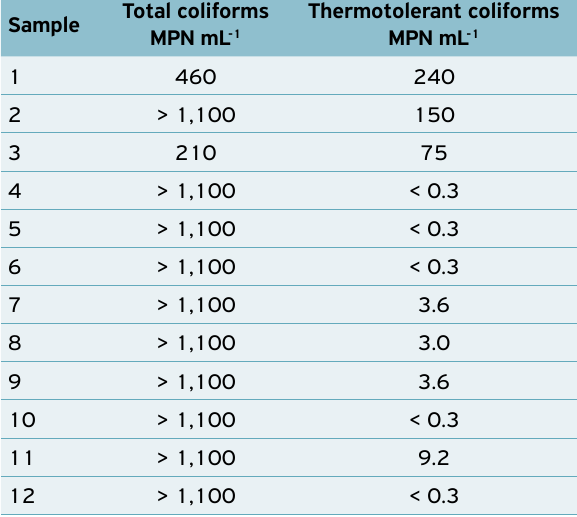
Table 2. Counts of total and thermotolerant coliforms in unprocessed cooled fresh coconut water samples manually extracted by street